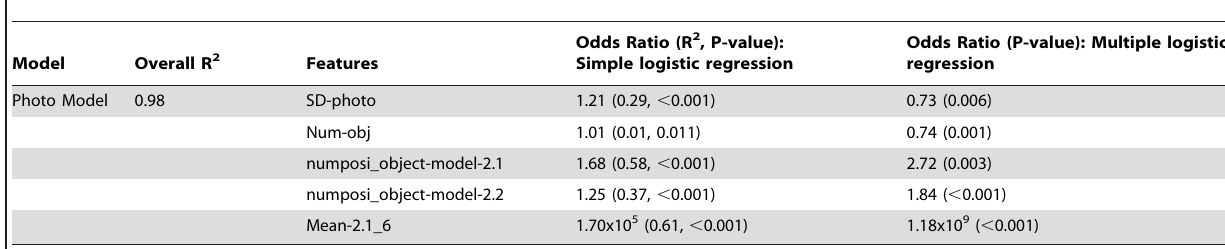
Table 3. Relevance of features from the best photo model in a univariate and multiple variable logistic regression.